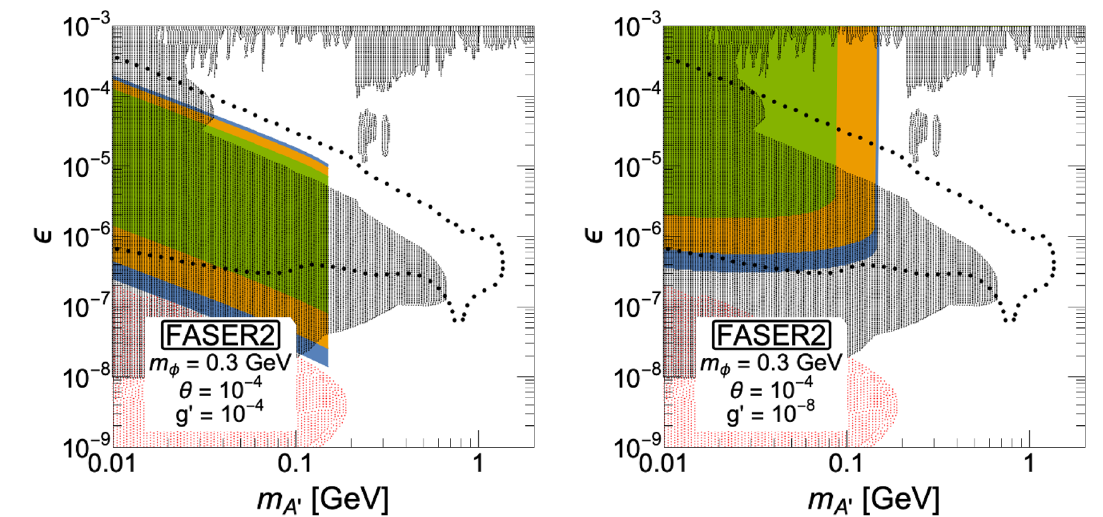
Figure 5 . The same plots as figure 2 for FASER 2. The parameters are taken as g 0 = 10 − 4 (left) and 10 − 8 (right) while other parameters are fixed as m φ = 2 . 0 GeV and θ = 10 − 4